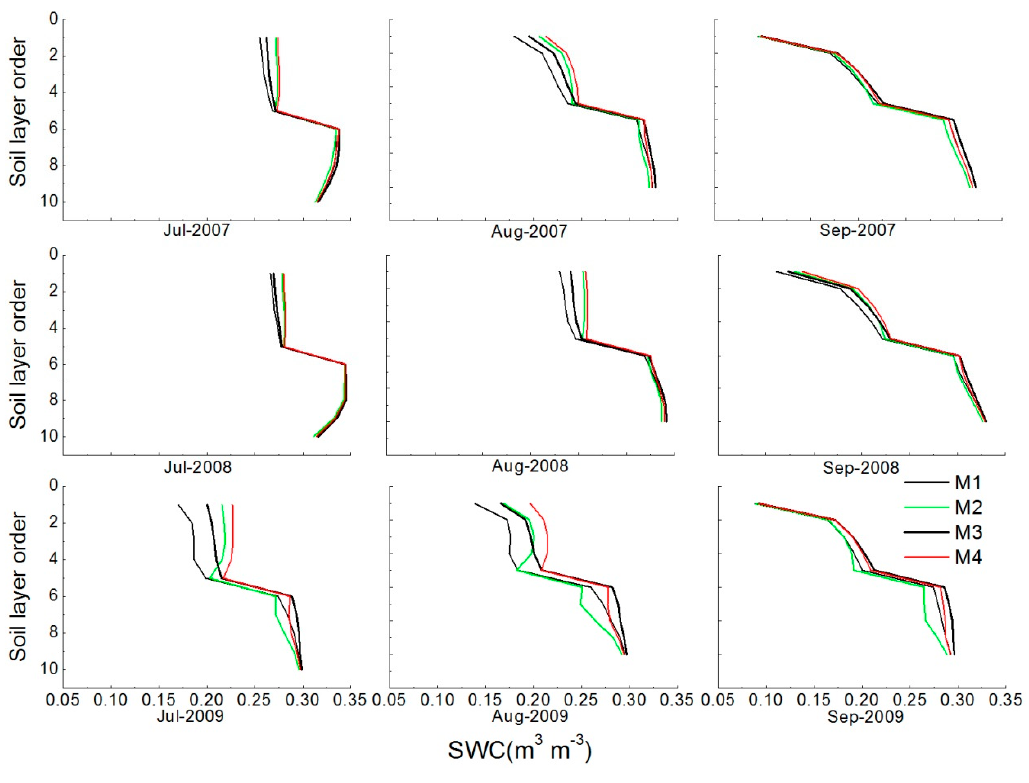
Figure 6. Comparison of the vertical variation in monthly mean simulated soil water content (SWC) values based on the different RWU schemes in July (7), August (8) and September (9) during